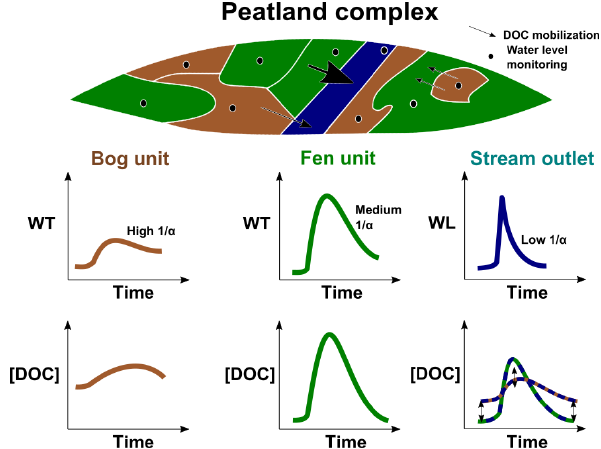
Figure 6. Schematic overview of a peatland complex. Size of the arrows corresponds to DOC quantity mobilized from distinct peat- land units. The DOC concentration observed in the stream depends on the contribution of the different peat units within the peatland